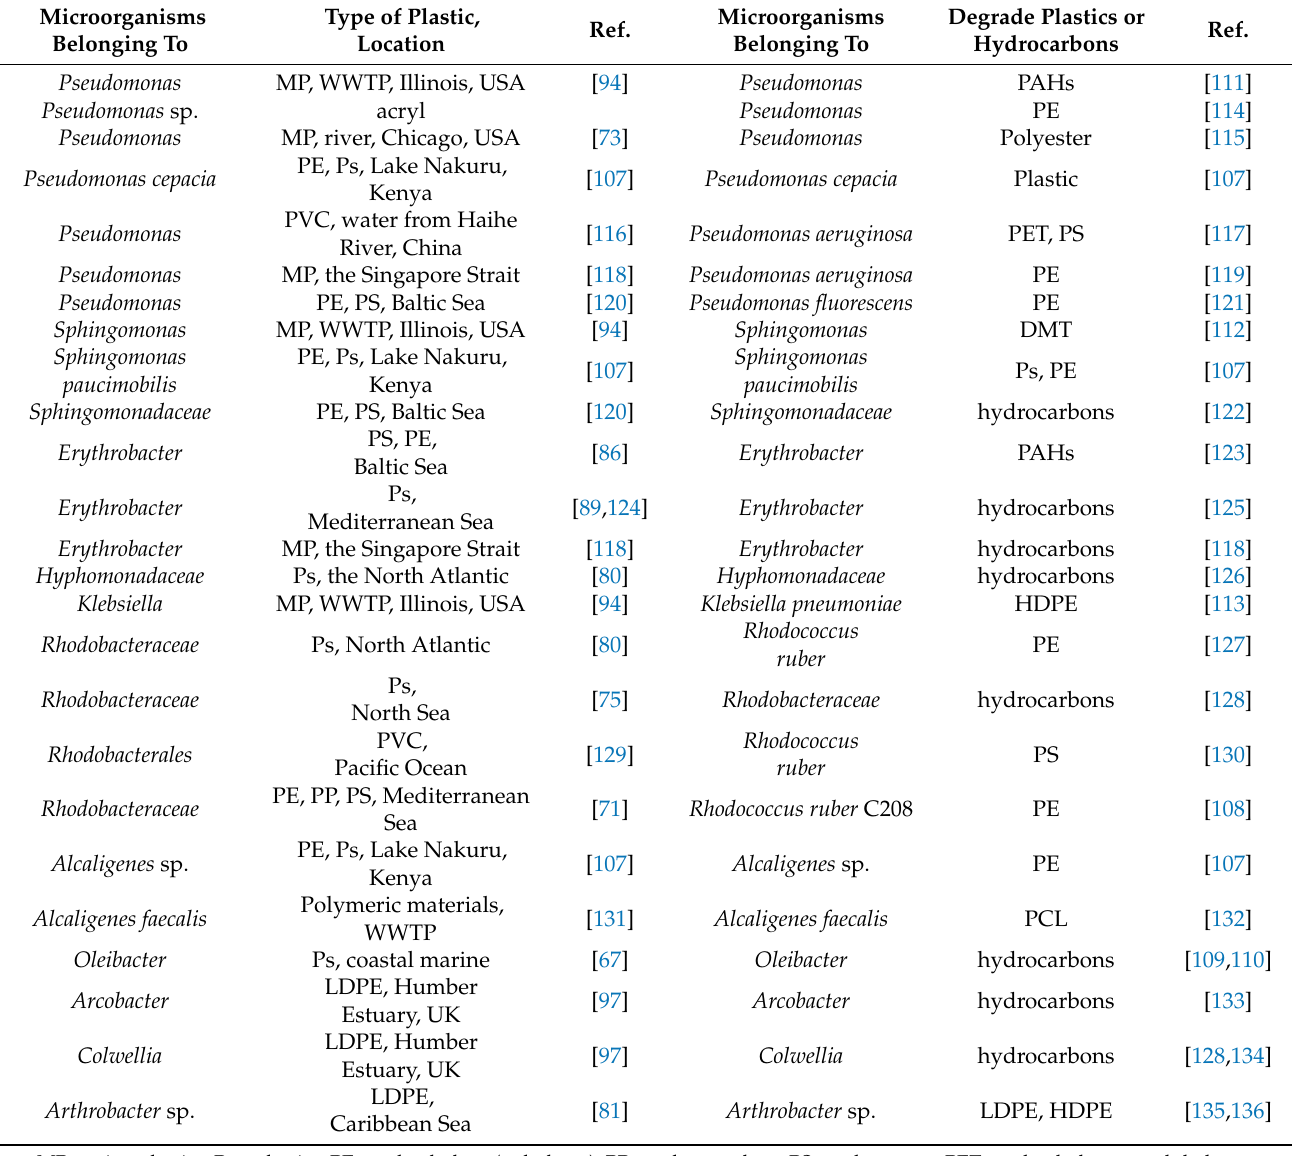
Table 2. Microorganisms found abundant on microplastics and the ability of representatives of these genera to degrade plastic or